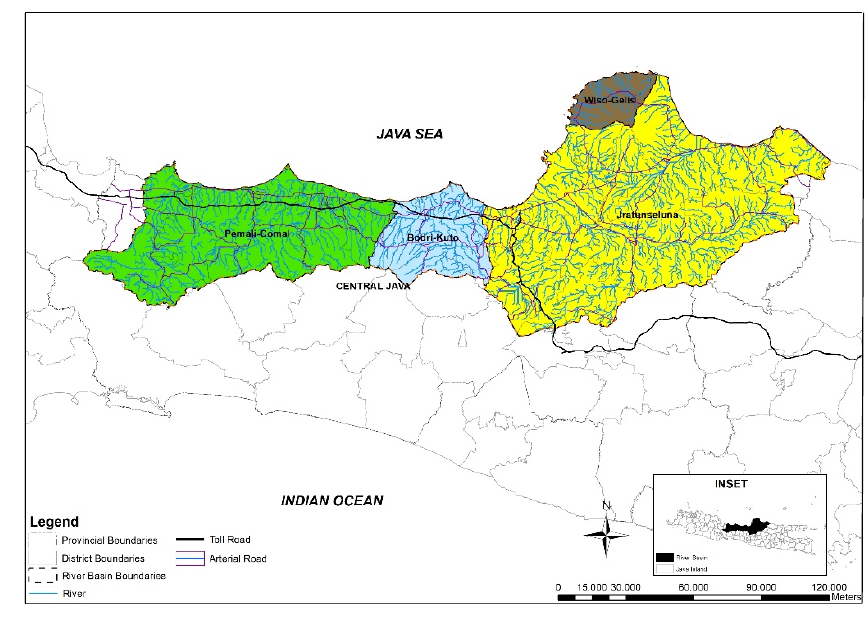
Figure 1. Study Area.